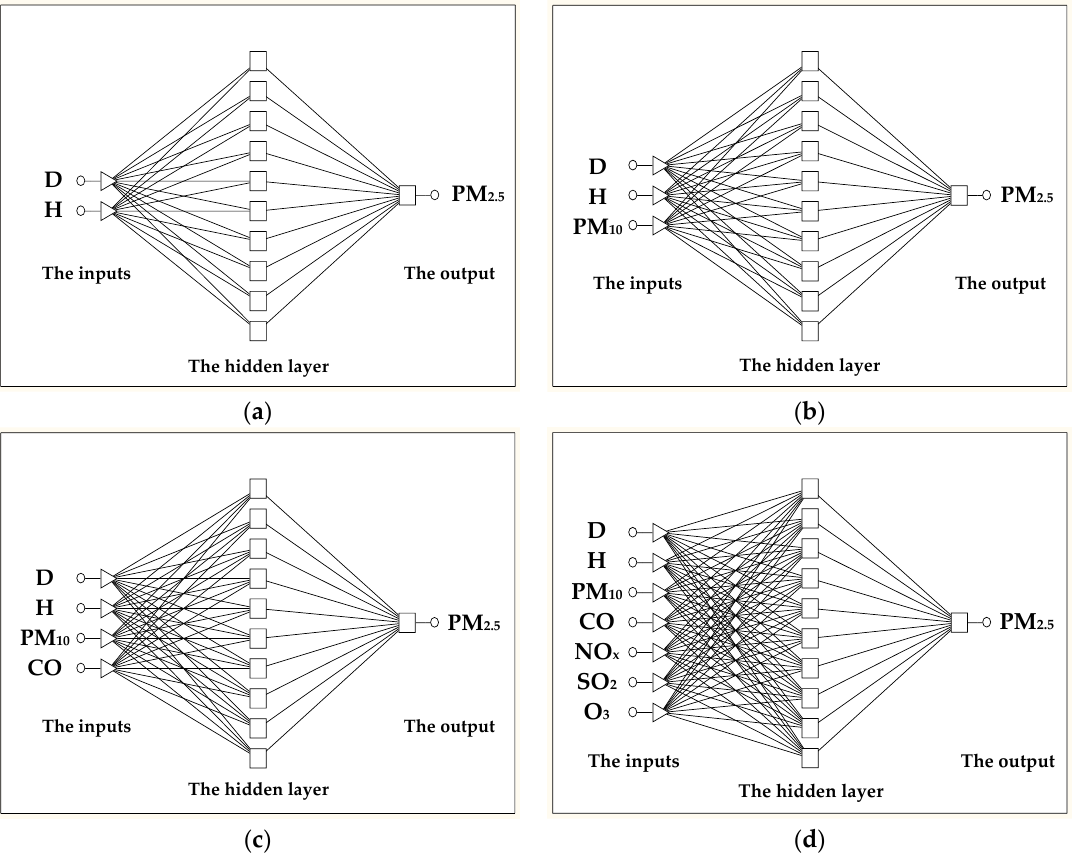
Figure 3. Architecture diagrams of the multilayer perceptrons with ten neurons in a single hidden layer. The diagrams for various variants of explanatory variables: ( a ) D, H; ( b ) D, H, PM 10 ; ( c ) D, H, PM 10 , CO; ( d ) D, H, PM 10 , CO, SO 2 , O 3 , NO x .